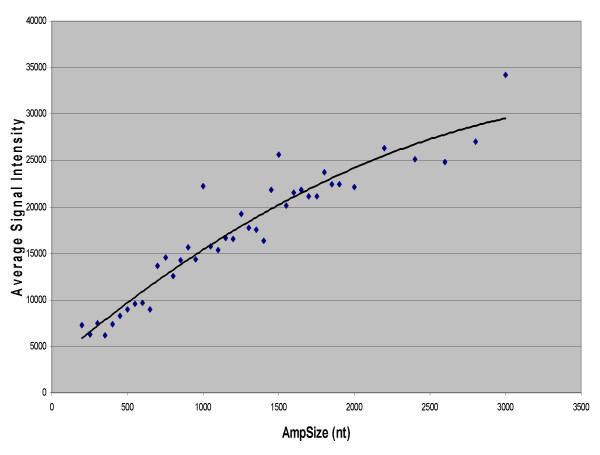
Variation in hybridization signal intensity with amplicon length. The average signal intensity in the control channel is plotted versus amplicon size. The amplicons were "binned" in 50 bp increments (to 1900 bp) then in 200 bp increments (from 2000 to 3000 bp). There were only 4 amplicons of size over 3000 bp.